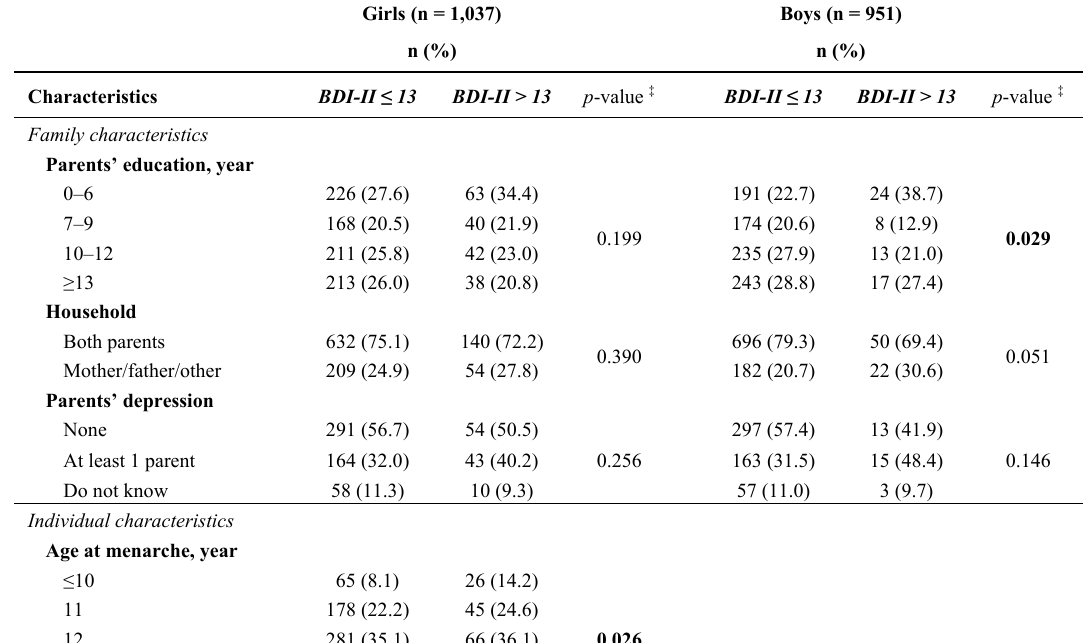
Table 2. Prevalence of depressive symptoms (BDI-II > 13) according to adolescents’ characteristics for girls and boys (Porto, Portugal 2003–2004) (n =